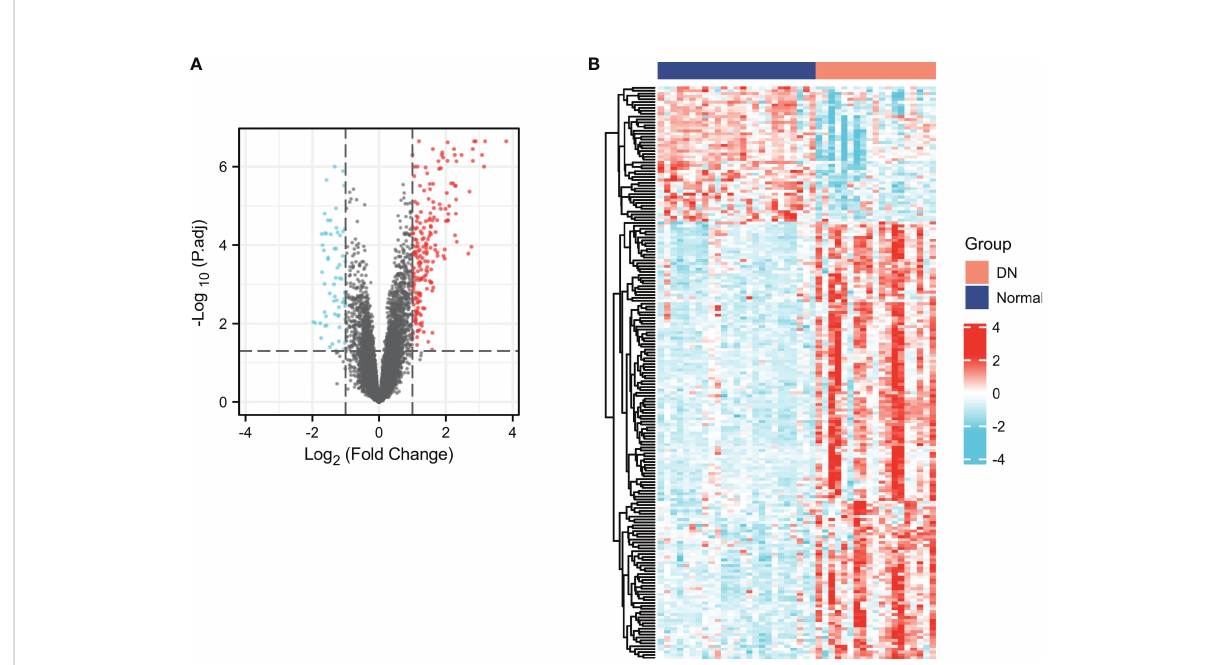
FIGURE 2 Screening for DEGs in DN. Volcano (A) and heatmap (B) plots of the DEGs. For the volcano, the blue dots indicated the down-regulated genes and the red dots indicated the up-regulated genes. For the heatmap, the red group is the DN group, while the dark blue group is the normal group. The down-regulated genes are presented in blue, and up-regulated genes are presented in